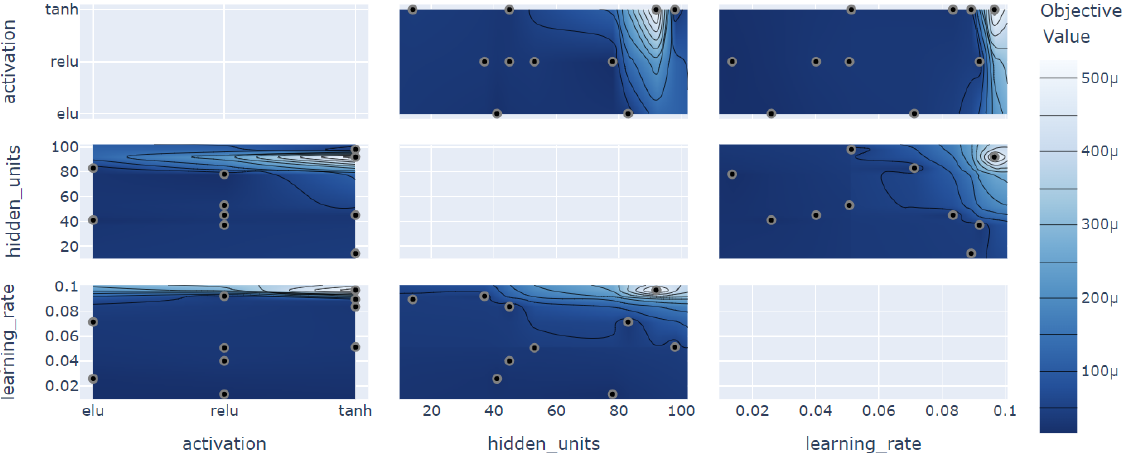
Figure 5. Hyperparameter optimization with